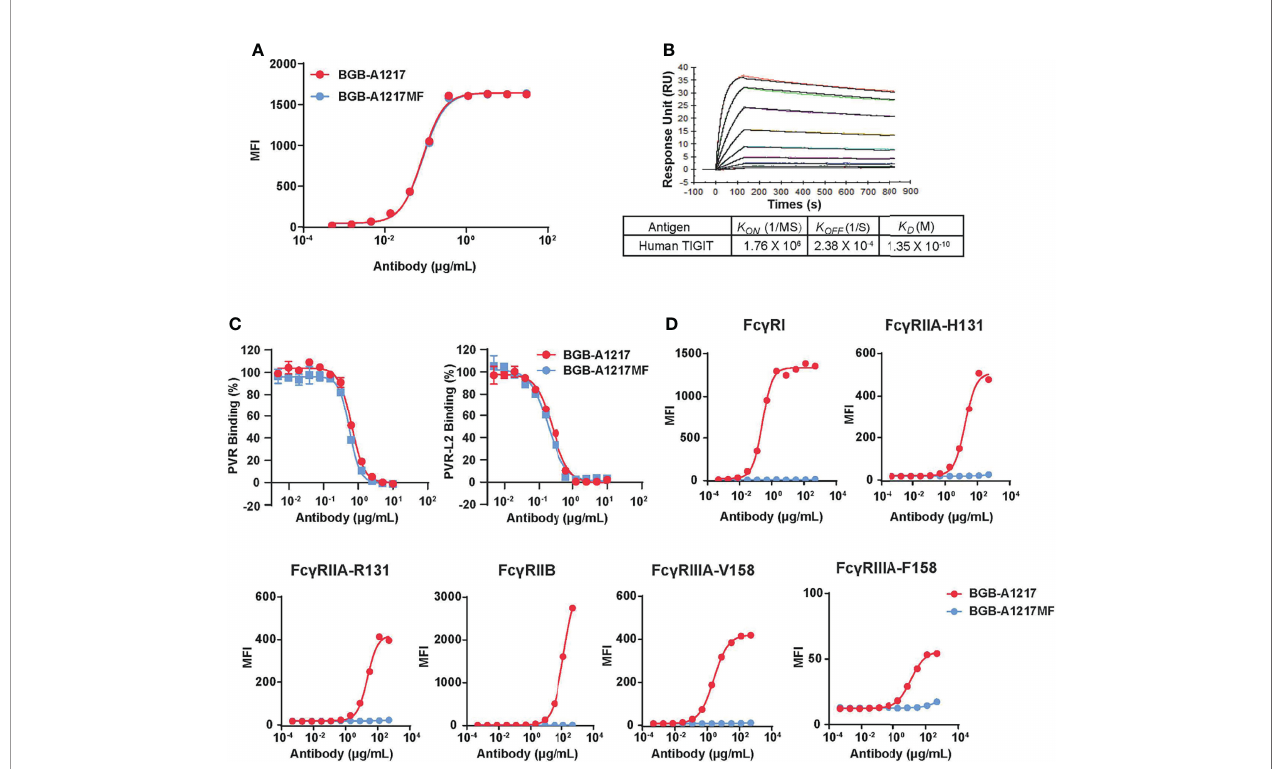
FIGURE 1 | BGB-A1217 and BGB-A1217MF bind to TIGIT and block ligand interaction with comparable potency, while display different af fi nities to Fc g Rs. (A) binding of BGB-A1217 or BGB-A1217MF to TIGIT-expressing cell line BW5147.3/TIGIT assayed by FACS. (B) SPR sensorgrams of BGB-A1217 to human TIGIT assayed using BIAcore. Y-axis, response unit (RU). X-axis, reaction time course, seconds. (C) Cell-based ligand competition assay. TIGIT-mIgG2a was incubated with HEK293/ PVR or HEK293/PVR-L2 cells in the presence of increasing amounts of BGB-A1217 or BGB-A1217MF. Inhibition rate was calculated based on the TIGIT binding signal. (D) binding of BGB-A1217 or BGB-A1217MF to Fc g R-expressing cell lines assayed by